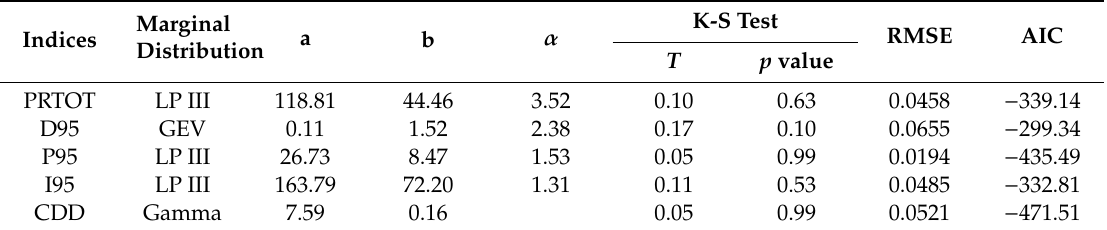
Table 2. Statistical test results for marginal distribution of five precipitation indices of Qindu station.